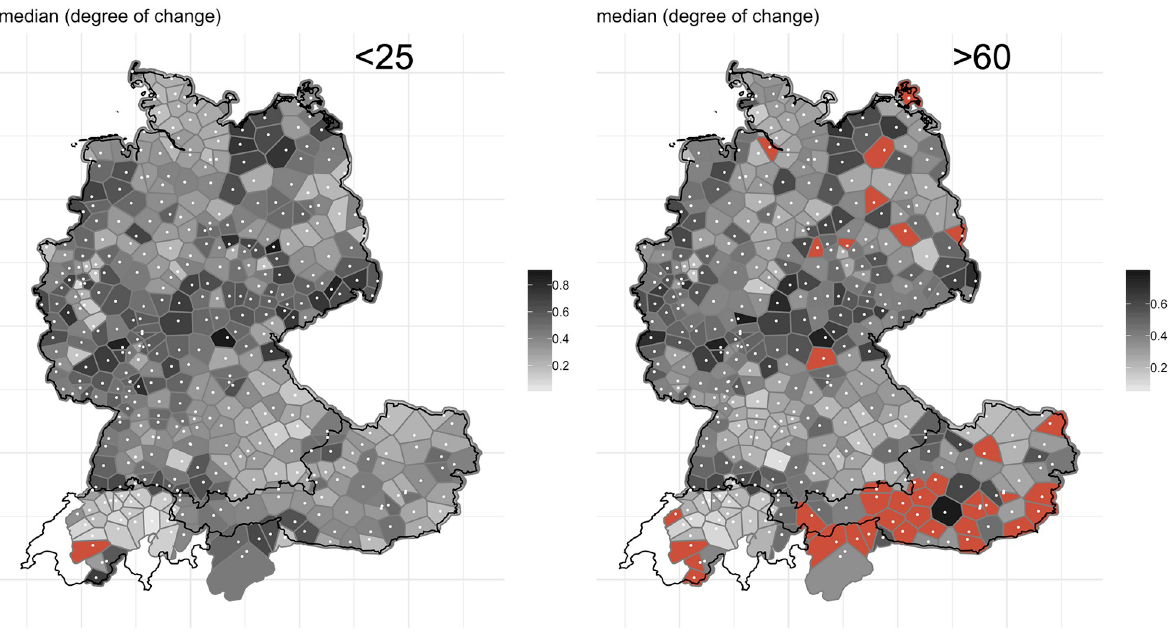
Fig 16. Aggregated change for users < 25 years old (left) and users > 60 years old